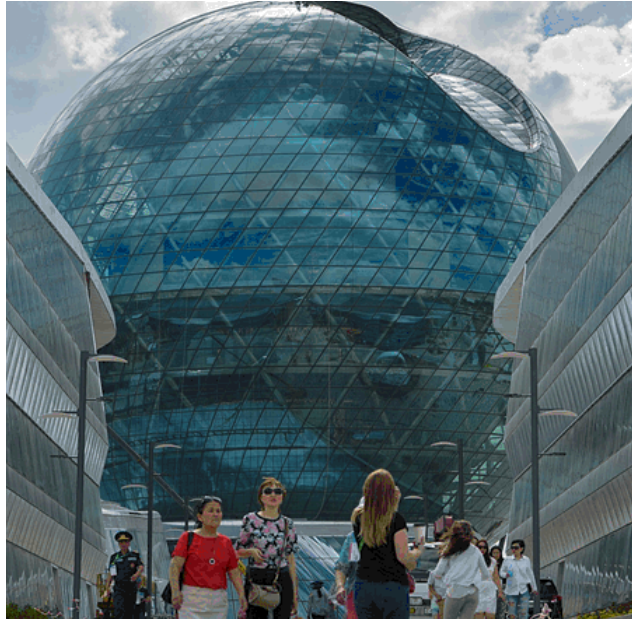
Fig. 1 Glass Sphere and pavilions of the EXPO 2017 in Astana